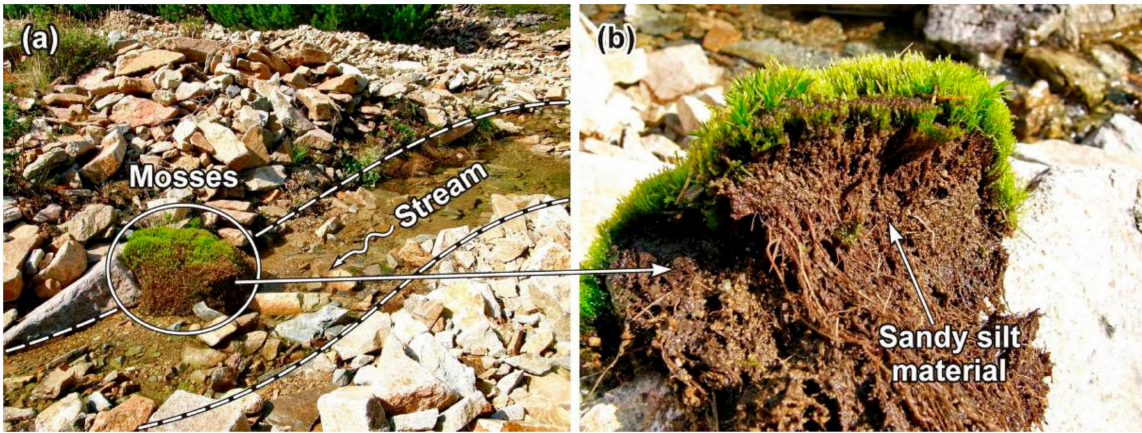
Figure 10. Moss cushion growing in the upper reaches of the stream ( a ) and its captured sandy silt material of alluvium ( b